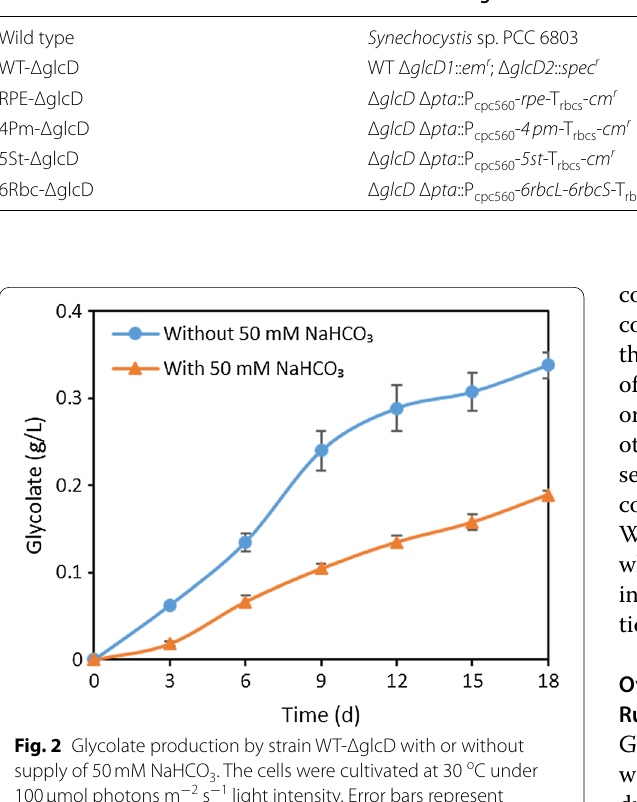
and 0.02 µmol L − 1 OD 730 − 1 respectively, when supple- mented with or without 50 mM NaHCO 3 (Additional file 1: Fig. S2). Moreover, the extracellular glycolate con- centration was undetectable in the WT strain under both conditions (data not shown). It is evident that glycolate could be rapidly metabolized in the WT strain. On the contrary, strain WT-ΔglcD accumulated glycolate intra- cellularly and extracellularly under both conditions (Fig. 2 and Additional file 1: Fig. S2). The intracellular gly- colate concentration of strain WT-ΔglcD was 0.51 µmol L − 1 OD 730 − 1 when supplied with 50 mM NaHCO 3 , and increased to 1.75 µmol L − 1 OD 730 − 1 without the supply of NaHCO 3 (Additional file 1: Fig. S2). Furthermore, the gly- colate concentration in the medium of strain WT-ΔglcD reached 86.47 µmol L − 1 OD 730 − 1 (mass concentration of 0.02 g/L) and 317.77 µmol L − 1 OD 730 − 1 (mass concen- tration of 0.06 g/L) after 3 days cultivation respectively, with or without 50 mM NaHCO 3 (Fig. 2). Apparently, the majority of glycolate was excreted to the culture by strain WT-ΔglcD, and the intercellular glycolate accumulation